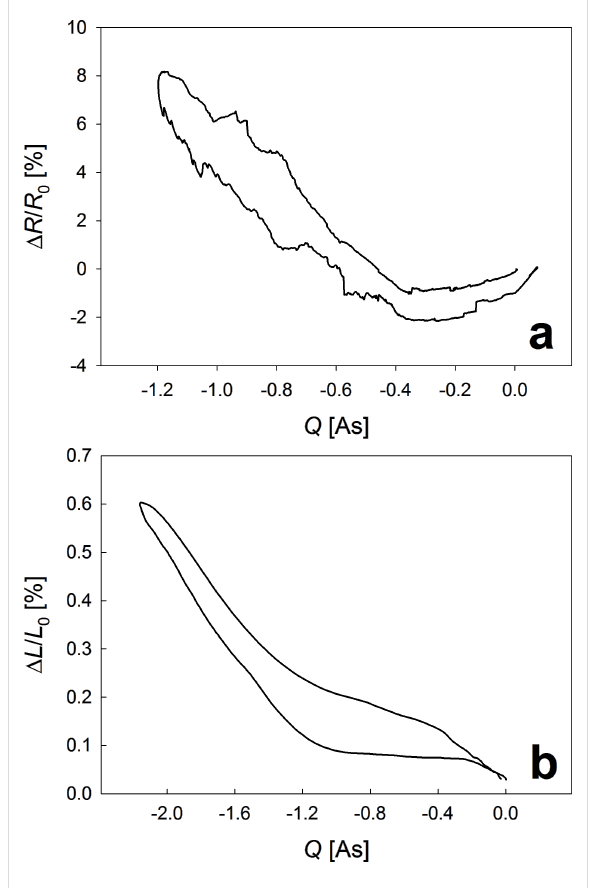
Figure 2: Charge dependence of relative electrical resistance (a) and sample thickness (b) upon cyclic voltammetry in the hydrogen regime at potentials U Ag/AgCl between − 1000 mV and − 550